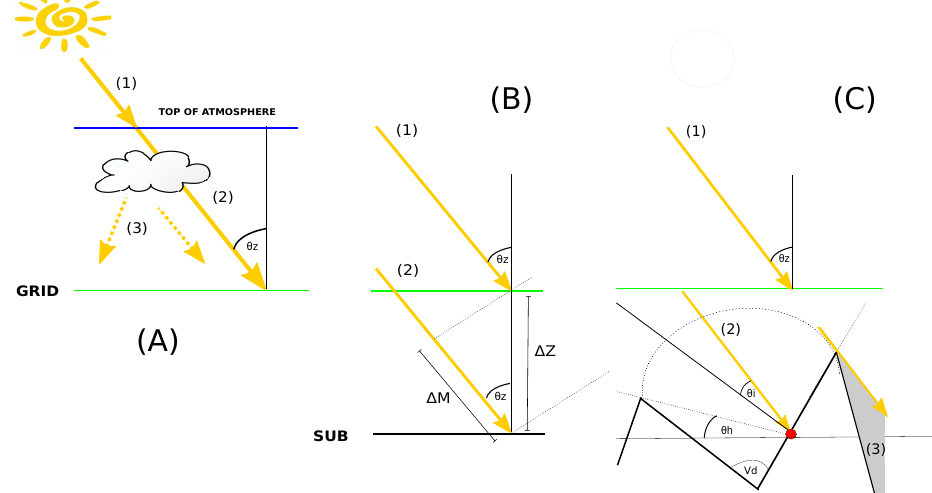
Fig. 3. Solar radiation scheme. (A) SW ↓ at GRID is partitioned into direct (1) and diffuse (3) components through a clearness index by ratioing against extraterrestrial radiation (1). (B) An elevation correction is applied to SW ↓ dir and θ z . (C) Topographic correction is applied accounting for illumination angle, θ i , horizon angle, θ h and sky view factor V d .